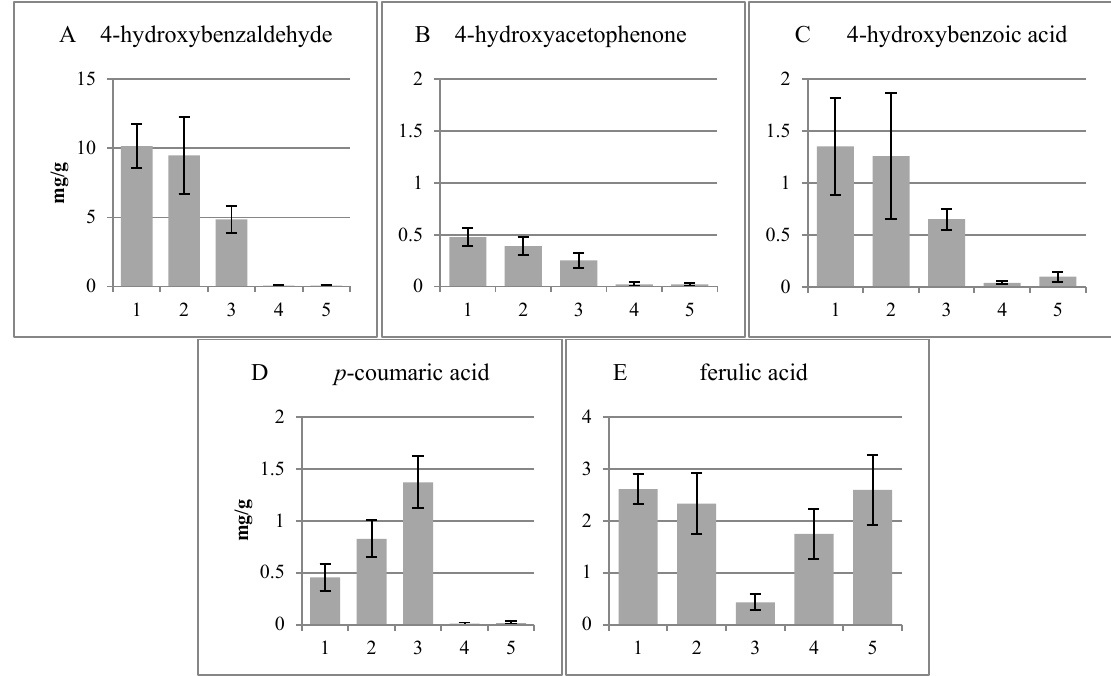
Figure 3. p -Hydroxyl phenols ( A – C ) and hydroxycinnamyls ( D , E ) released by the CuO treatment. 1, Cork cambium; 2, non-conductive phloem; 3, combined conductive phloem, cambium and differentiating xylem; 4, lignified xylem; 5, previous year’s